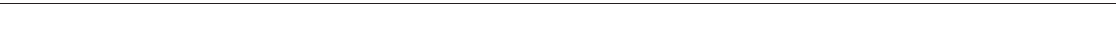
Fig. 7 Assessment of Meteor functionality. a Expression measured by qRT-PCR of Meteor lncRNA and ME/Cardiac Mesoderm-related genes in P19CL6 cells following CRISPR-On-mediated Meteor lncRNA induction. Mean ± SEM ( n = 6). p values were calculated using a two-tailed t test. (* P < 0.05; ** P < 0.01; *** P < 0.001). b Expression measured by qRT-PCR of Meteor lncRNA , Nanog , Eomes , T , Gsc and Nkx6-3 in ESCs following transfection with siRNAs